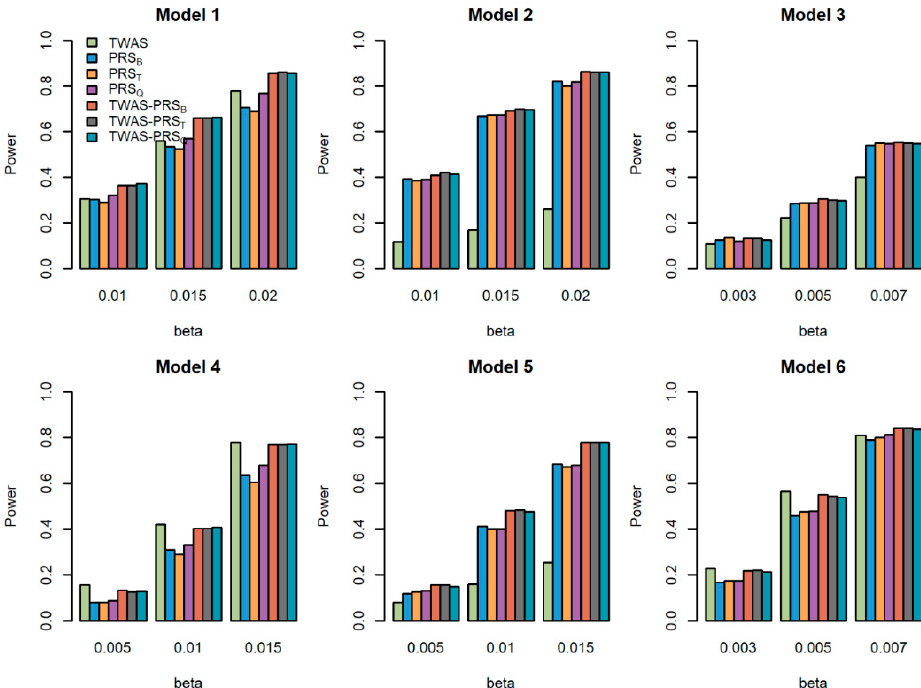
Figure 2. Powers of the seven tests versus the total effect size β for quantitative traits with N = 10,000 . The proportion of causal variants is 0.2. Models 1–3 correspond to genes 1–3, for which we only used the eQTL with the largest weight to generate the gene expression; Models 4–6 correspond to genes 1–3, for which we used two eQTLs with the first two largest weights to generate gene expression.